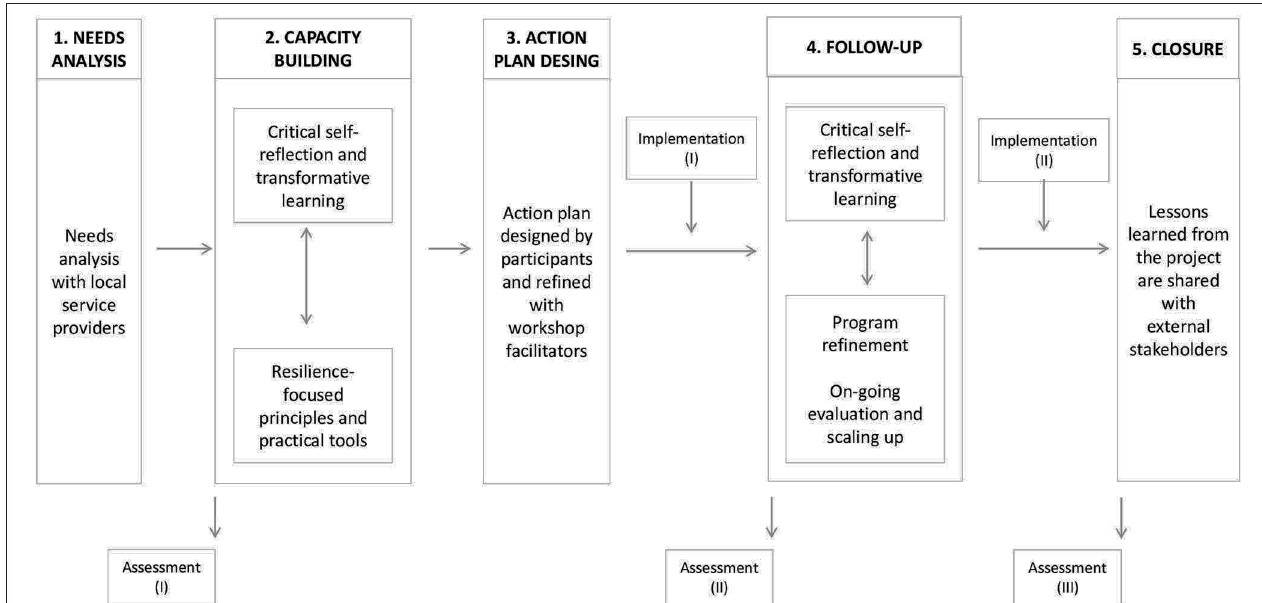
FIGURE 1 | The five phases of the ToR